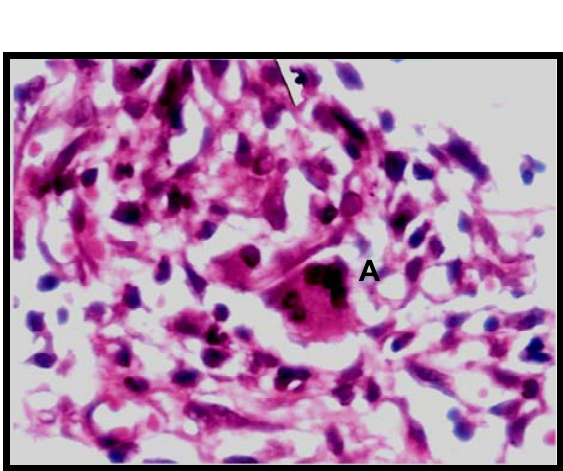
FIGURA 9 – Fotomicrografia de lâmina de um animal do grupo